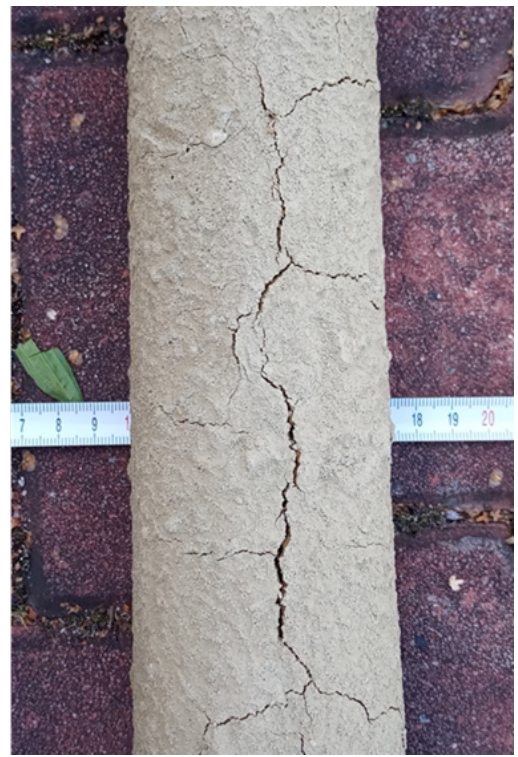
Figure 8. The state of the tube shape surface of the micropile after being pulled out of the ground.